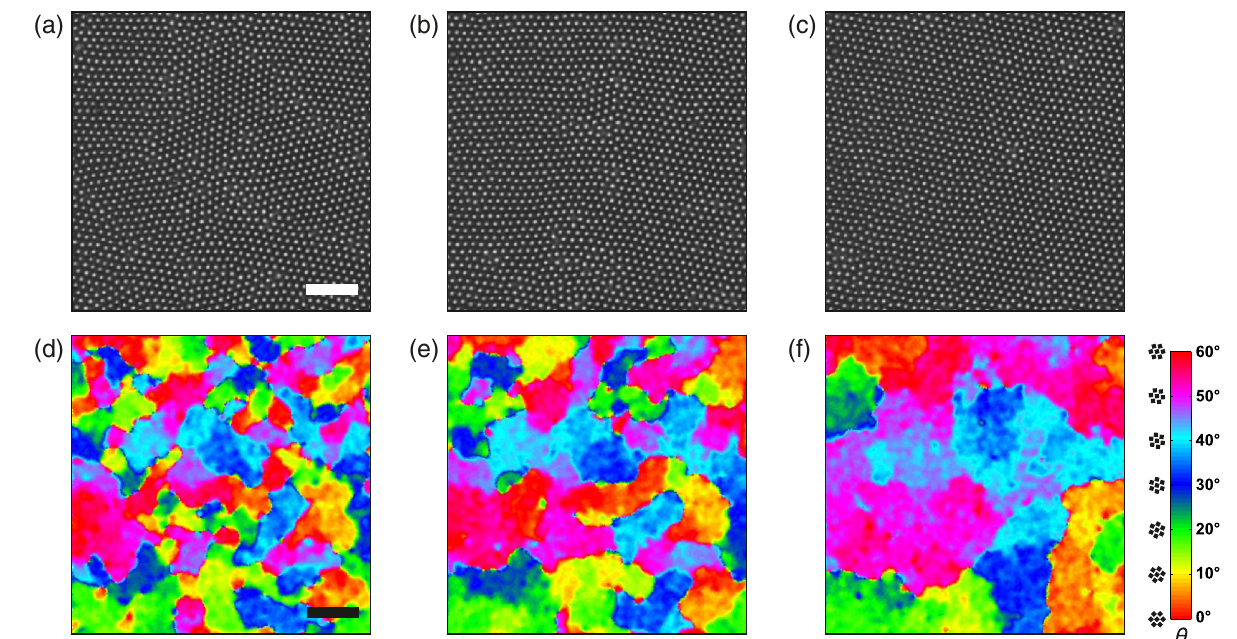
FIG. 1. (a) – (c) Microscopy images of the colloidal polycrystalline monolayer at different times during grain growth: (a) 32 t (b) 100 t , and (c) 1000 t . The scale bar represents 20 μ m. (d) – (f) The corresponding smoothed orientation fields (full field of view) at B B the same times. The scale bar represents 100 μ